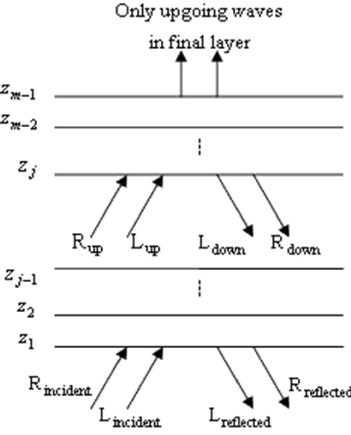
Figure 2. The propagating electromagnetic waves in the horizon- tally stratified media (R means the right-hand polarized wave and L represents the left-hand polarized wave)